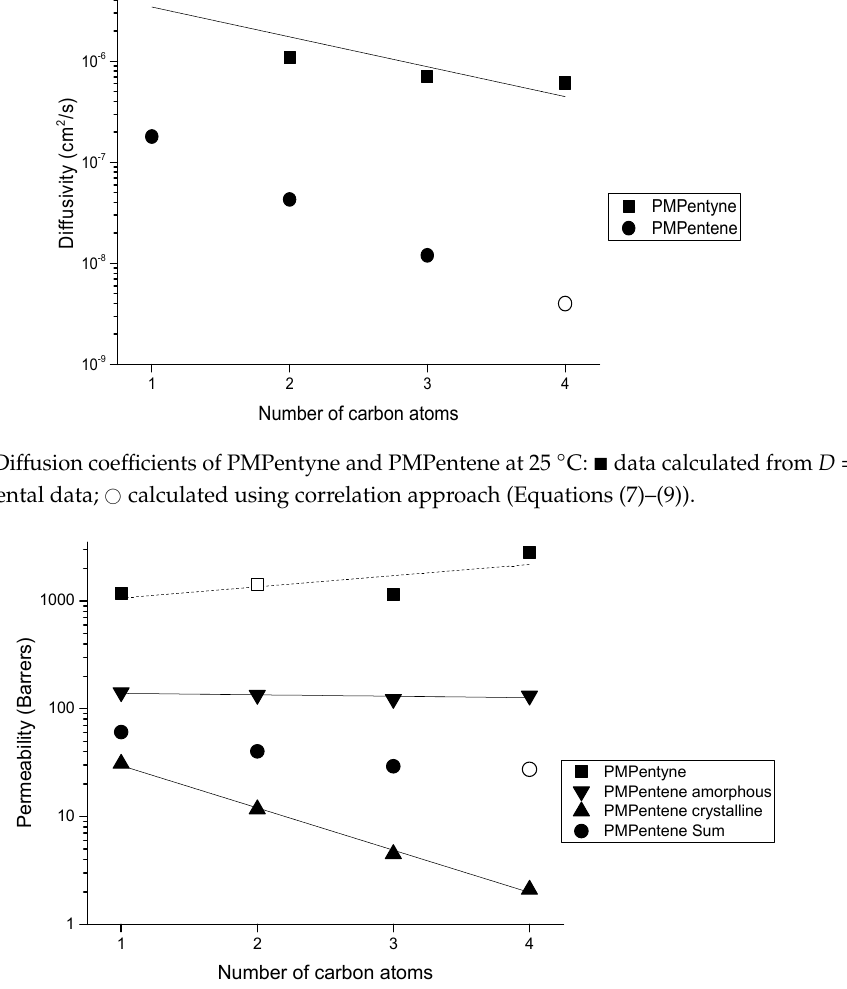
80 °C: experimental data; , data calculated using two-phase model (Equations (2) and (3)); Figure 8. PermeabilitycoefficientsofPMPentyneandPMPentene(withamorphous-crystallinedispersion) extrapolated from experimental data; , data calculated using correlation approach (Equations (7)–(9)). Figure 8. Permeability coefficients of PMPentyne and PMPentene (with amorphous-crystalline dispersion) at at 80 ◦ C: • experimental data; (cid:78) , (cid:72) data calculated using two-phase model (Equations (2) and (3)); (cid:4)